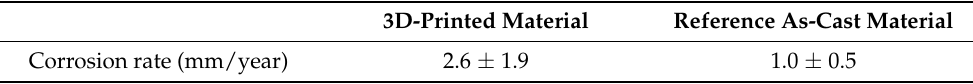
Table 5. Results of immersion tests in SBF solution at 37 ◦ C.